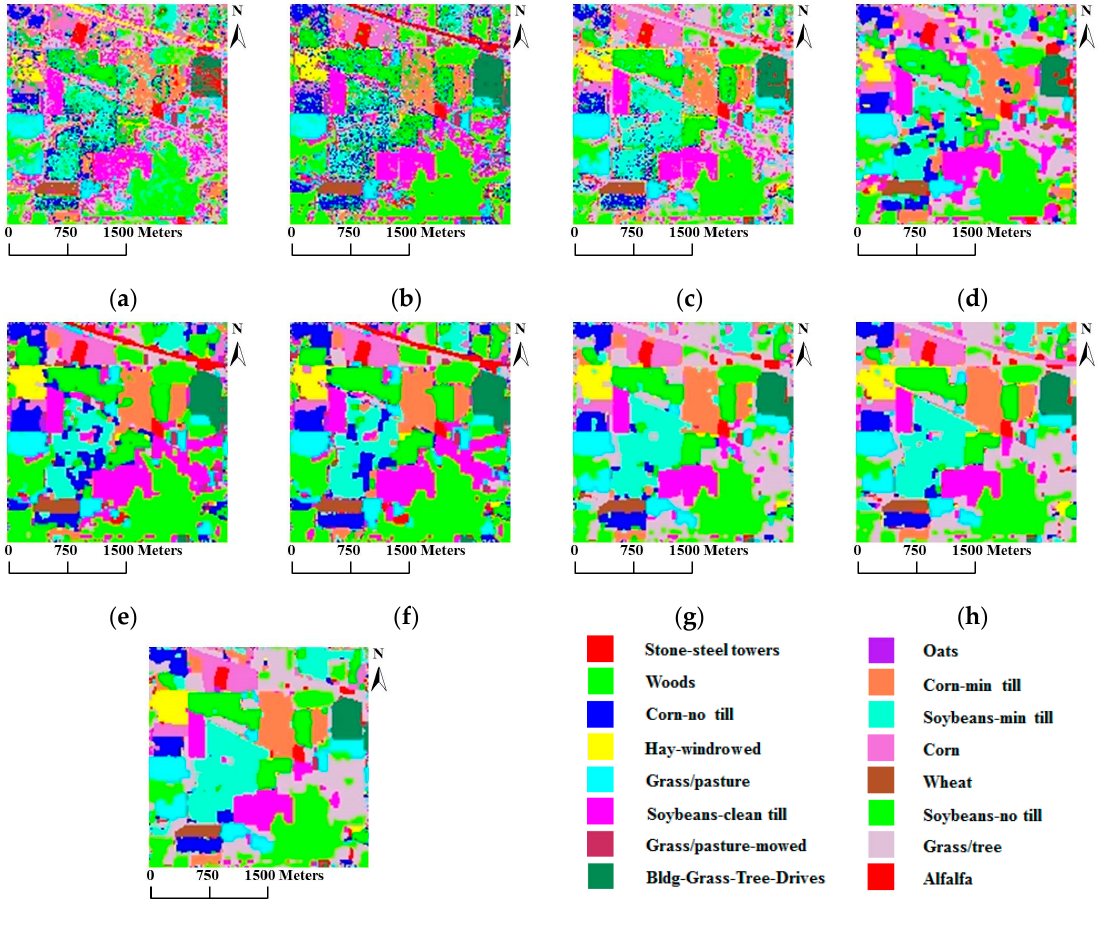
Figure 5. Classification/segmentation maps produced by the various tested methods for the AVIRIS Indian Pines scene (overall accuracies are reported in parentheses). ( a ) SVM (58.47%); ( b ) MLRsub (67.62%); ( c ) SVMsub (77.78%); ( d ) SVM-MRF (75.72%); ( e ) MLRsub-MRF (84.20%); ( f ) MLRsub-aMRF (85.66%); ( g ) SVMsub-MRF (89.49%); ( h ) SVMsub-eMRF (90.57%); ( i ) SVMsub-aMRF